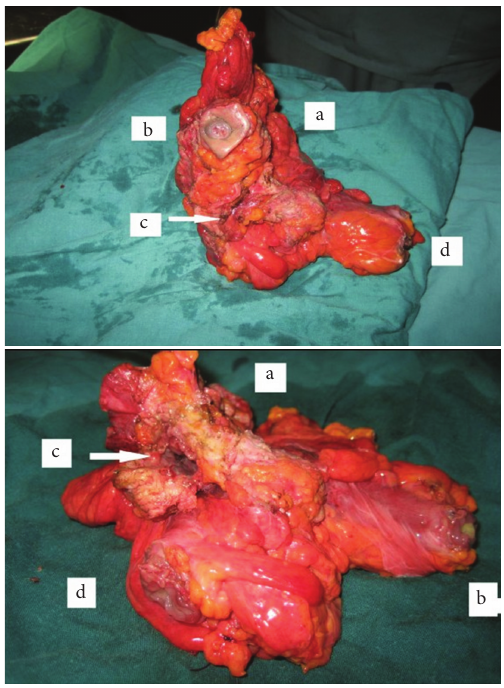
Figure 3: Operative specimen: An en bloc excision of the urachus mass (a), umbilicus (b), a bladder cuff (c), and sigmoid colectomy